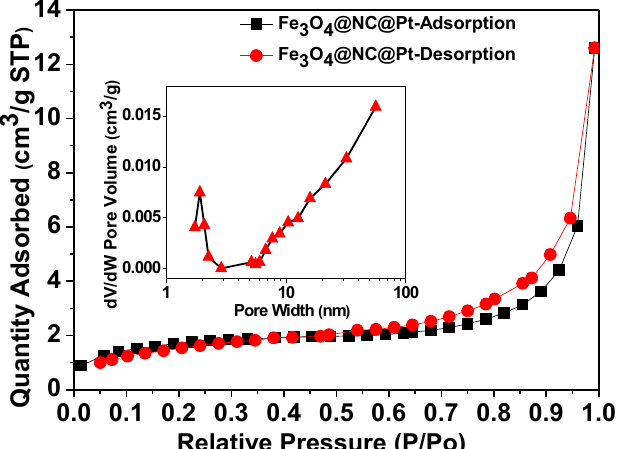
Figure 3. N 2 adsorption/desorption isotherms of Fe 3 O 4 @NC@Pt and BJH pore size distribution (inset).